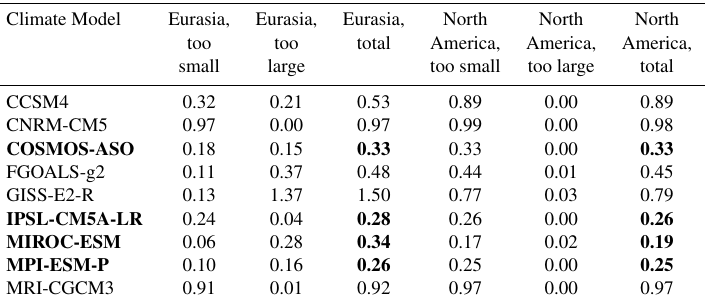
Table B1. Shown here are the percentages of ice extent that is too large or too small compared to the reconstruction by Abe-Ouchi et al. (2015). These percentages are added to obtain a quality assessment for the preliminary simulations. Lower percentages indicate a better match to Abe-Ouchi et al. (2015). Simulations that stayed below the 40% threshold are depicted in bold. Climate Model Eurasia, Eurasia, Eurasia, North North North too too total